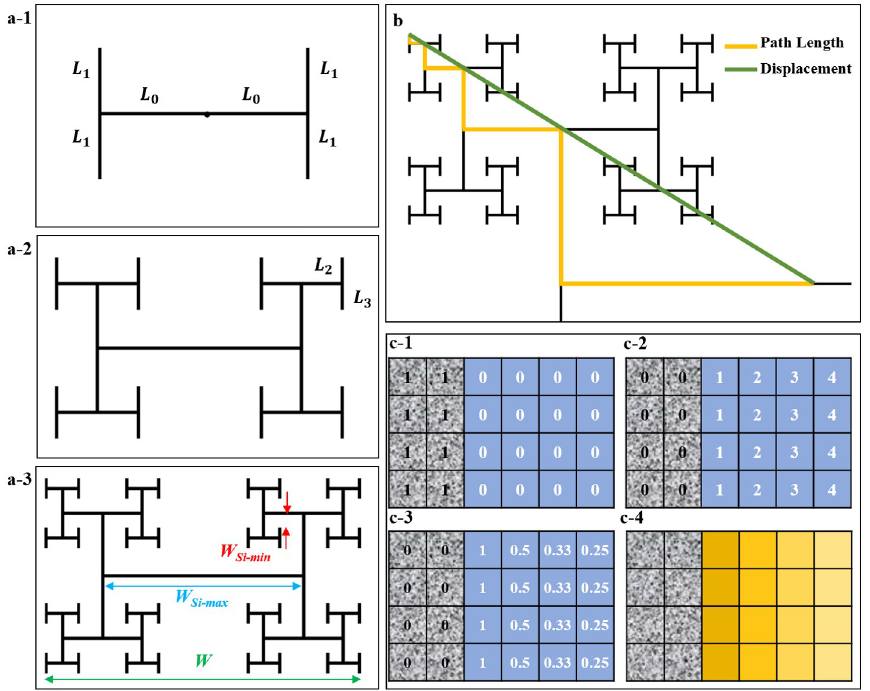
Fig 10. Schematics of various H-tree parameters. (a-1 to a-3) Schematics of consecutive stages in the generation of a D = 1.5 H-Tree featuring m = 3 repeating levels of the H pattern. In panel a-3, the pattern’s W Si-min , W Si-max , and total width W are marked. By incorporating branch segments ranging from L 0 to L N , we generated trees with m repeating levels of the H pattern (such that N = 2 m -1). (b) Schematic representation of the tortuosity calculation for an H-Tree. The yellow line is the path length from the H-Tree center to the end of the final repeating level and is the same for all endpoints. The green line is the displacement from the H-Tree’s center to the endpoint of fine-scale branch at the end of the yellow path length (for clarity, not all path lengths and displacements are shown). (c) Schematic demonstration of the conversion of the binary mask to the proximity heat map. (c-1) Matrix representation of the binary mask. The grey and blue pixels represent the VACNT and SiO 2 surfaces, respectively. (c-2) Each pixel value is substituted with the minimum distance to the branch pixel. (c-3) Gap pixel values in (c-2) are replaced by their inverse values. (c-4) Colors in the schematic heat map represent closeness to the nearest branch pixels.